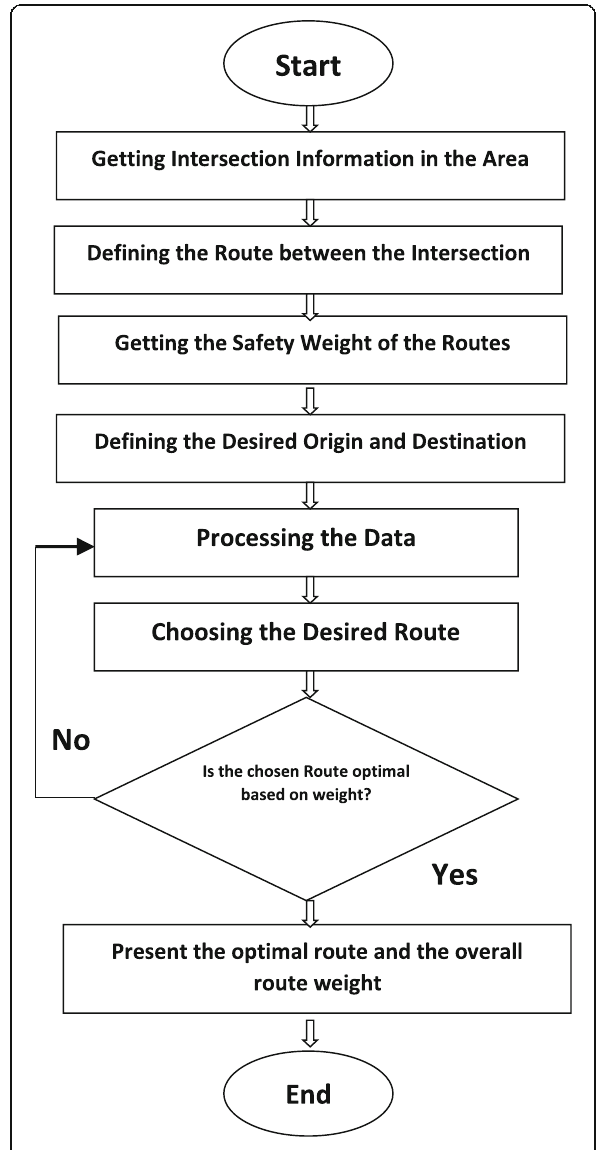
Fig. 4 Flowchart of Determining the Optimal Route for Emergency Evacuation and Relief by